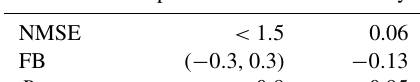
Table 3. Static values of the 2D pollutant dispersion simulation.